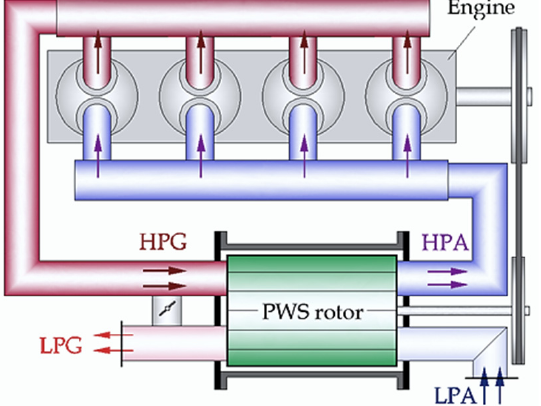
Figure 2. Pressure wave supercharger arrangement [6], Reprinted/adapted with permission from Ref. [12]. 2020, The Romanian Journal of Technical Sciences. Applied Mechanics.